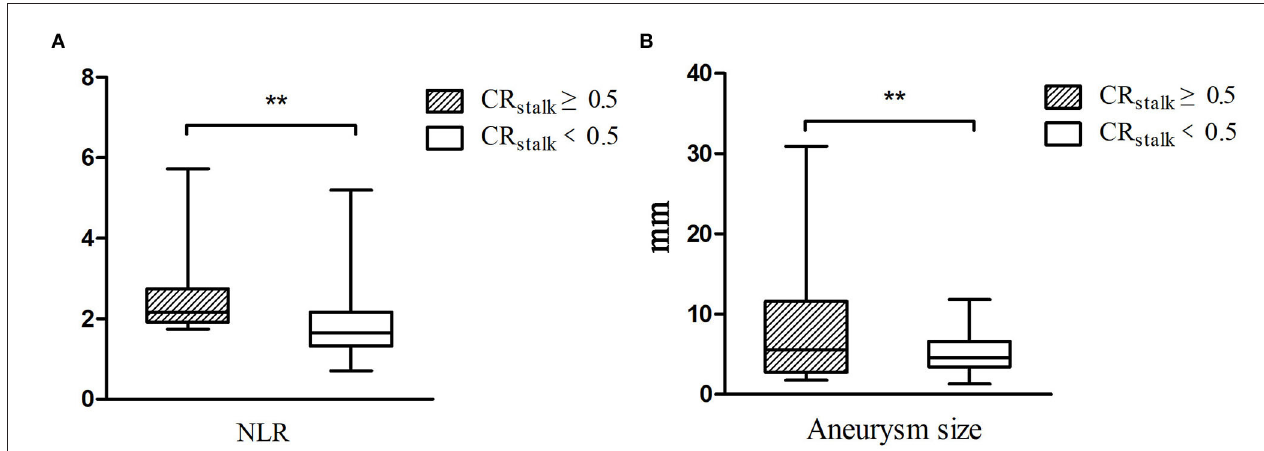
FIGURE 2 | The neutrophil-to-lymphocyte ratio (NLR) and aneurysm size were associated with CRstalk in patients with unruptured intracranial aneurysms. The level of NLR at admission was higher in the group with CRstalk ≥ 0.5 (A) , and the aneurysm size was larger in the group with CRstalk ≥ 0.5 (B) . **, p < 0.01.